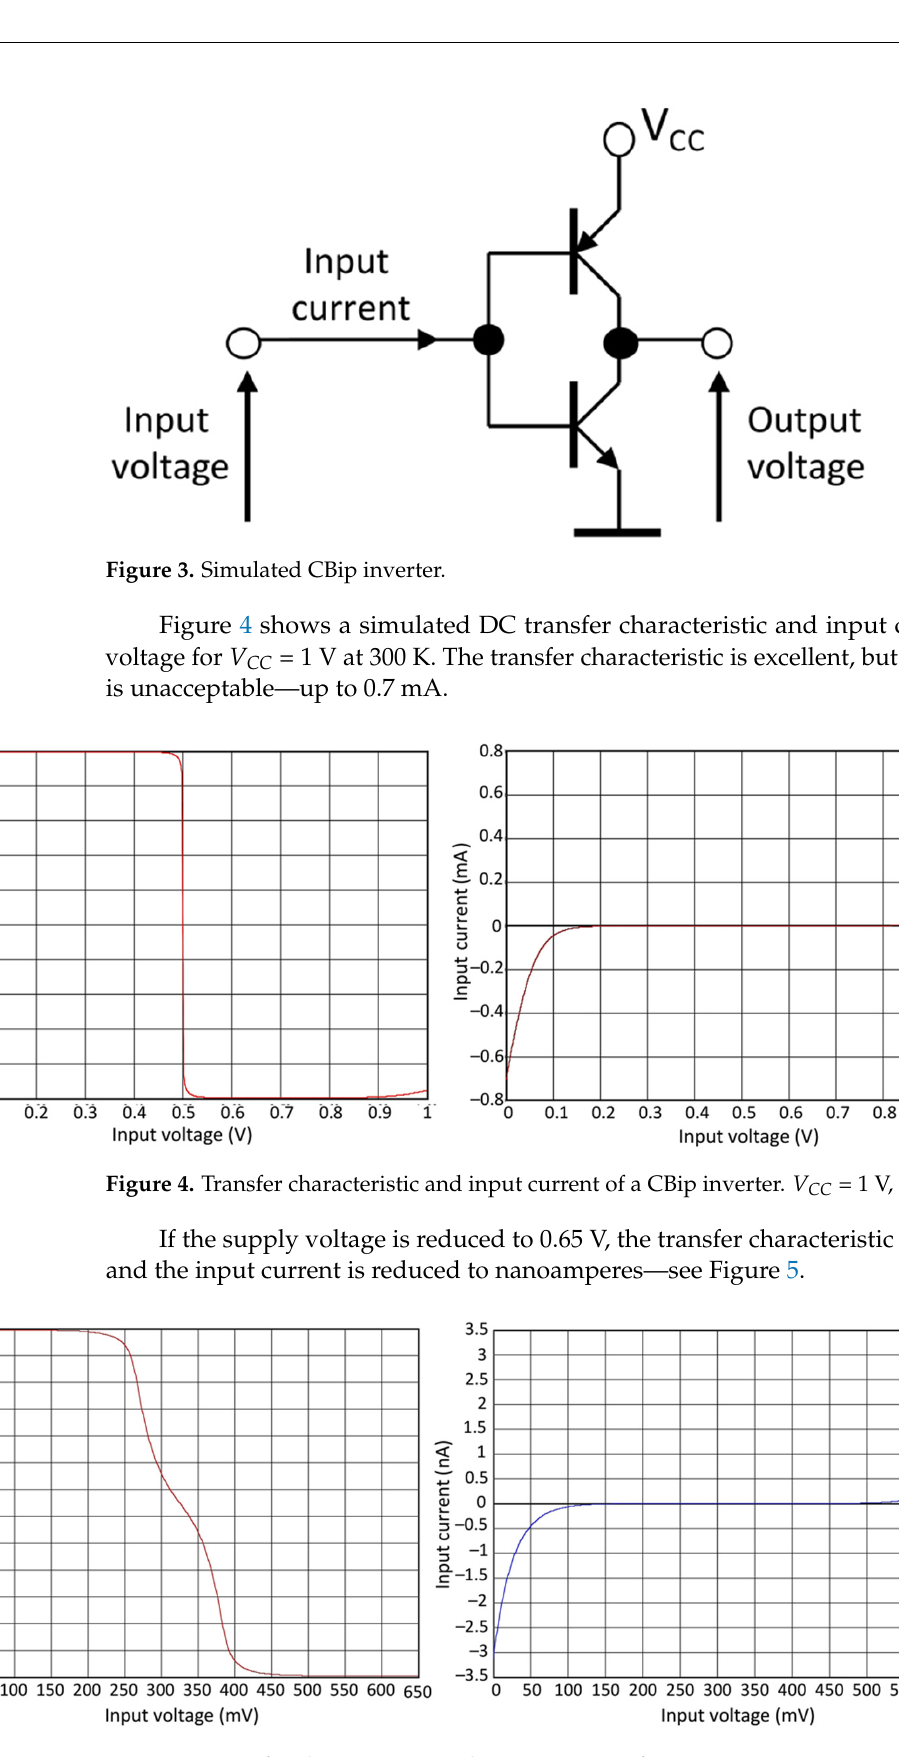
Figure 5. Transfer characteristic and input current of a CBip inverter. V CC = 0.65 V, temperature 300 K.